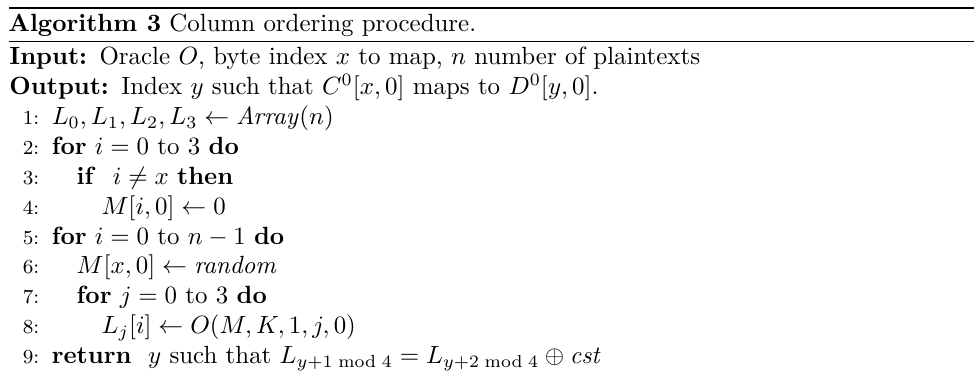
Algorithm 3 Column ordering